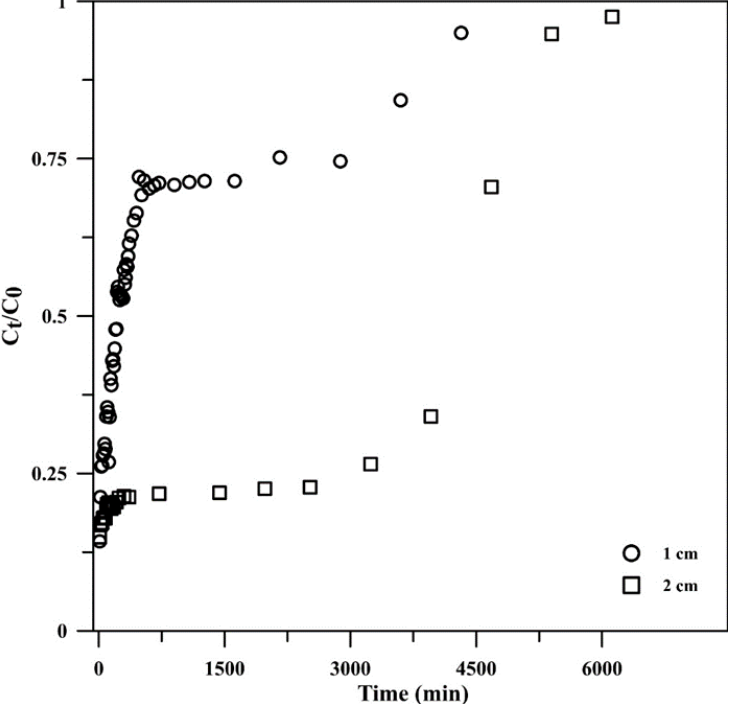
Figure 7. Breakthrough curves for phosphate adsorption onto monolithic Cry – CSH at different adsorbent heights ( C t / C 0 is the ratio of the effluent phosphate concentration at time t to the influent phosphate concentration).